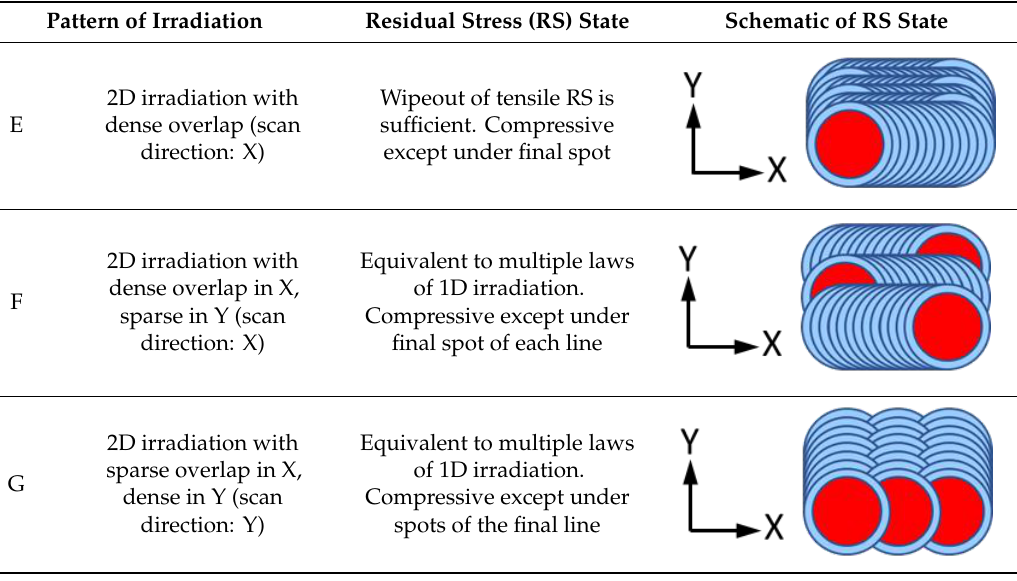
Table 3. Mechanical properties of HT1000 and SUS304.